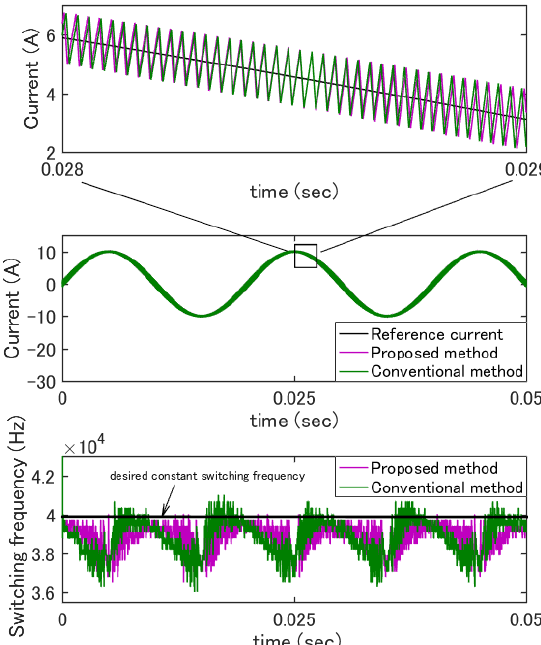
Figure 9. Current and switching period of the proposed method and conventional method for the desired switching frequency at 40